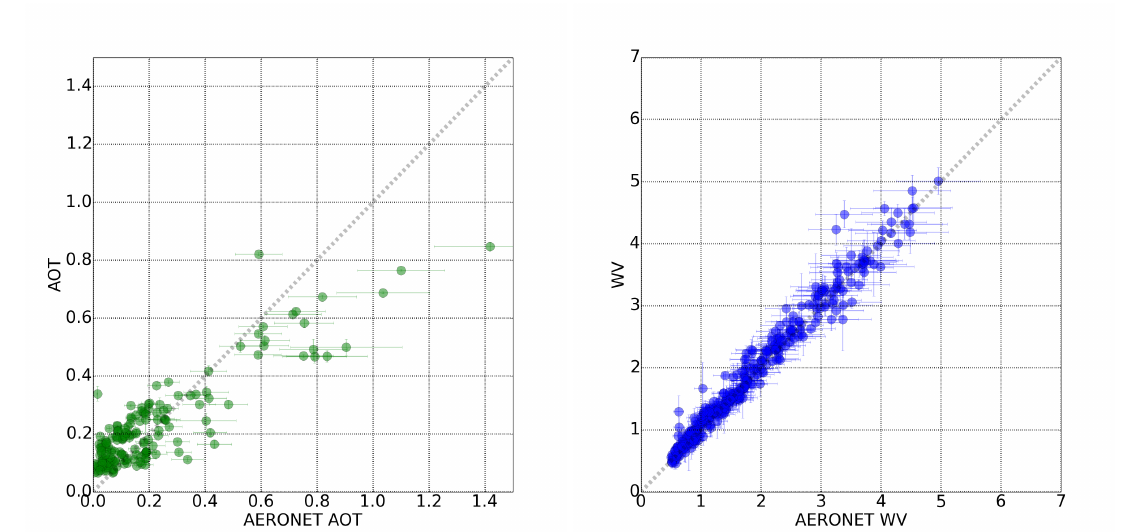
Figure 3. AOT ( left ) and WV ( right ) correlation plots between AERONET measurements and values retrieved by the remote sensing algorithm in a total of 494 Sentinel-2